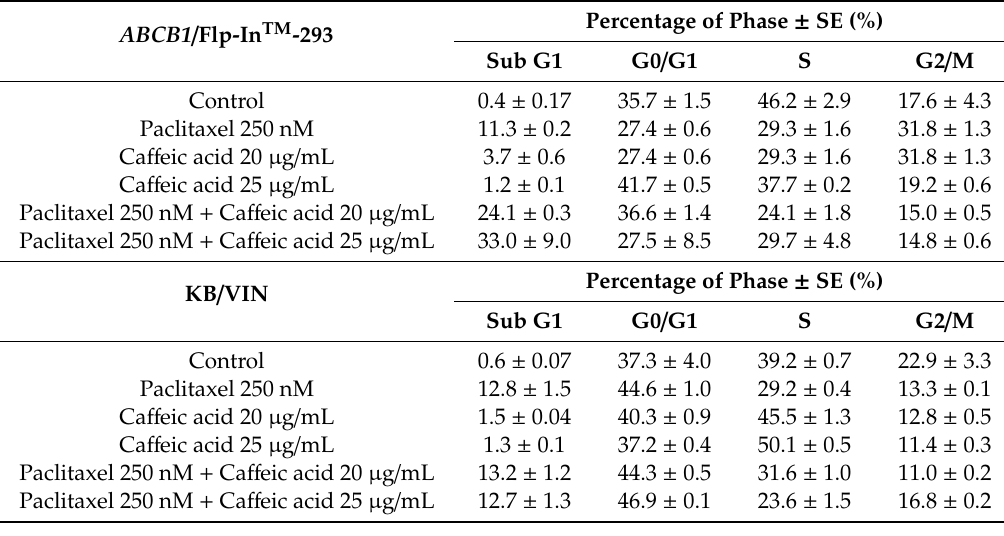
Table 3. The percentage of each cell cycle phase under various treatments in ABCB1 / Flp-In TM -293 cell line and KB / VIN cell